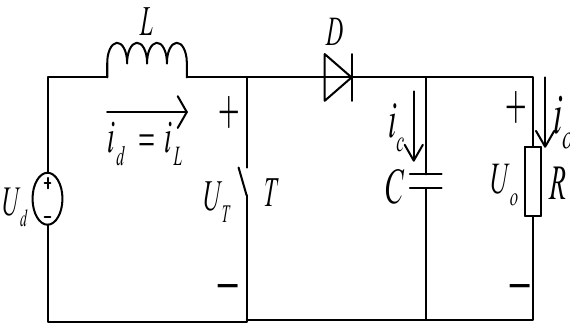
Figure 4. Boost type conversion circuit.